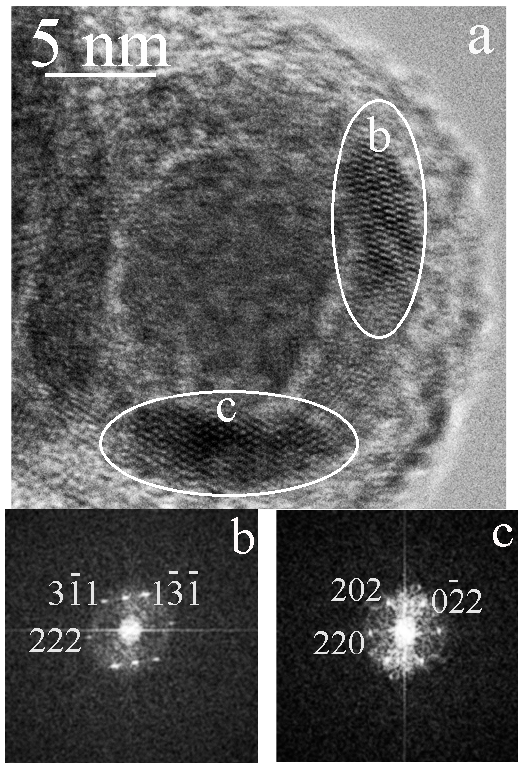
Figure 6. Carbon ‐ encapsulated nanoparticles containing iron: ( a ) two fragments b and c are marked with white ellipses in the surface layer; ( b , c ) are the corresponding FFT, both fragments correspond to the cubic phase of γ – Fe 2 O 3 (maghemite), the axes of zones [11 ‐ 2] and [ ‐ 111], respectively.